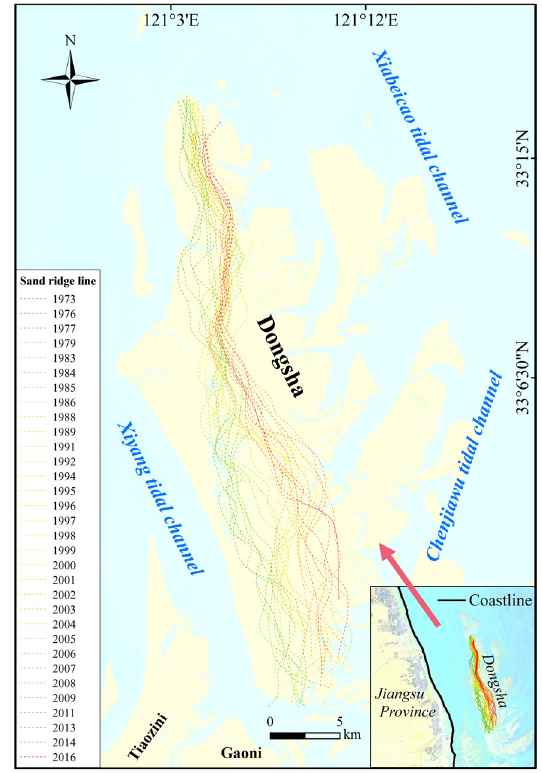
Figure 5. Changes in the sand ridgeline of Dongsha Shoal during